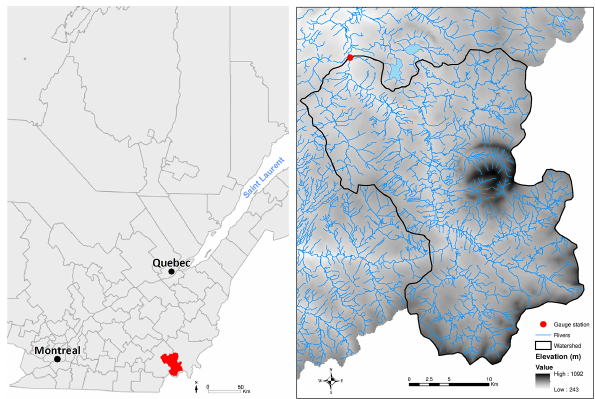
Figure 1. Localisation of the au Saumon catchment (738km 2 ;